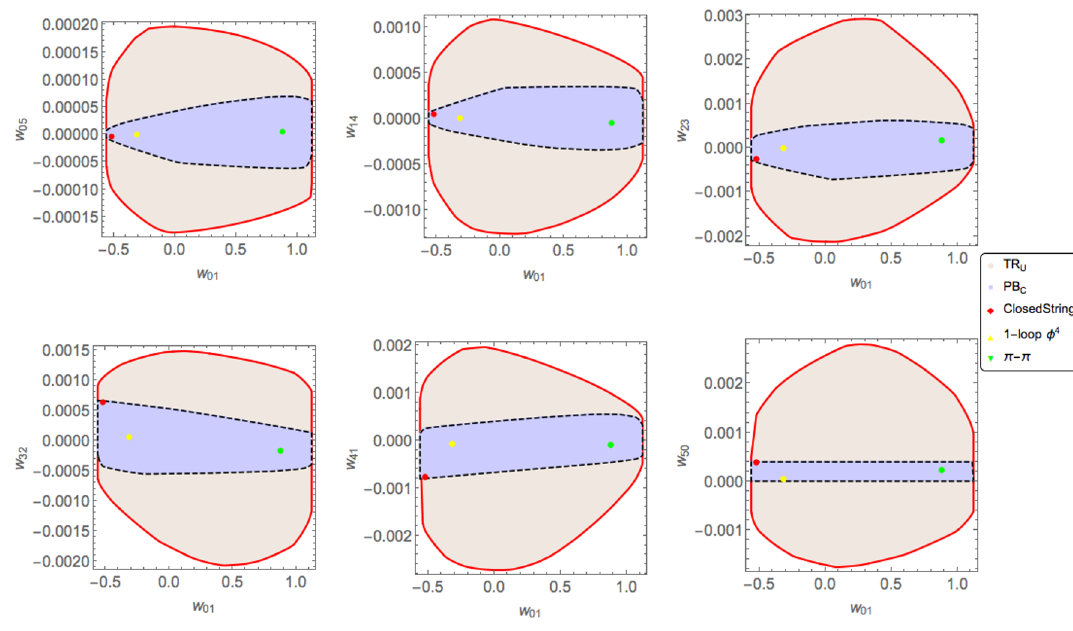
Figure 16. The comparison of the regions obtained for w 05 , w 14 , w 23 , w 32 , w 41 and w 50 with w 01